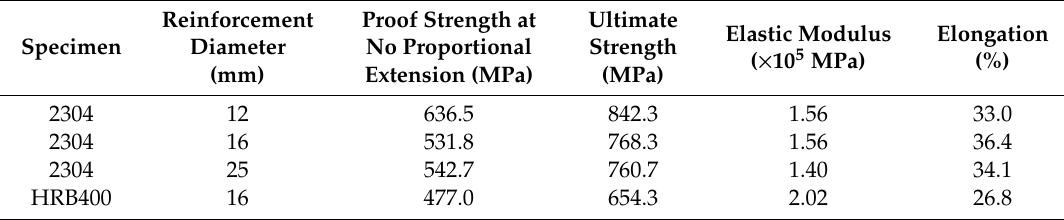
Table 1. Mechanical properties of reinforcement